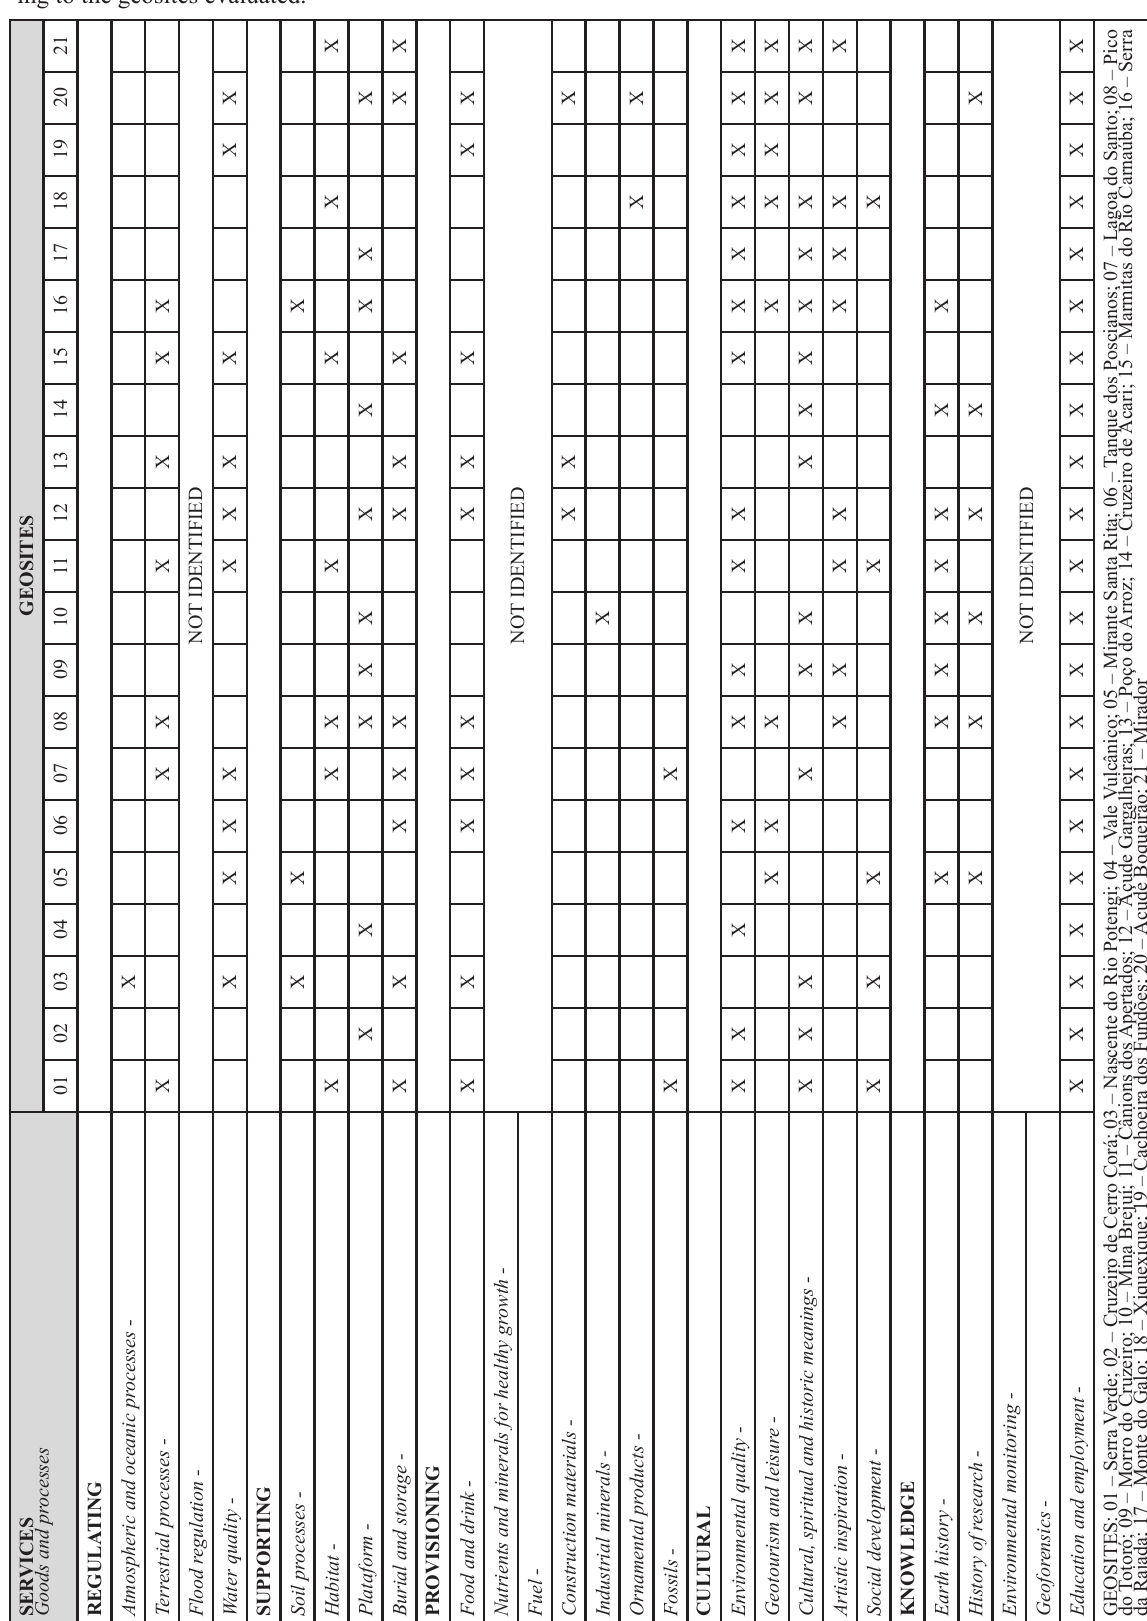
Table 3 . Synthesis of geodiversity ecosystem services identified in the area of the Seridó Aspiring Geopark accord- ing to the geosites